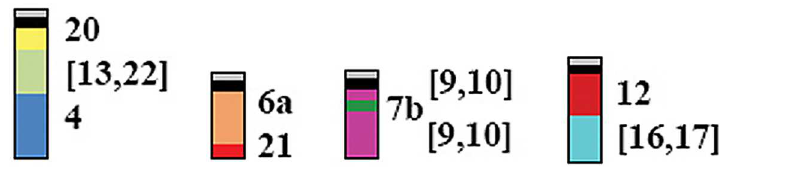
Fig 9. Possible synapomorphic characters of Neacomys